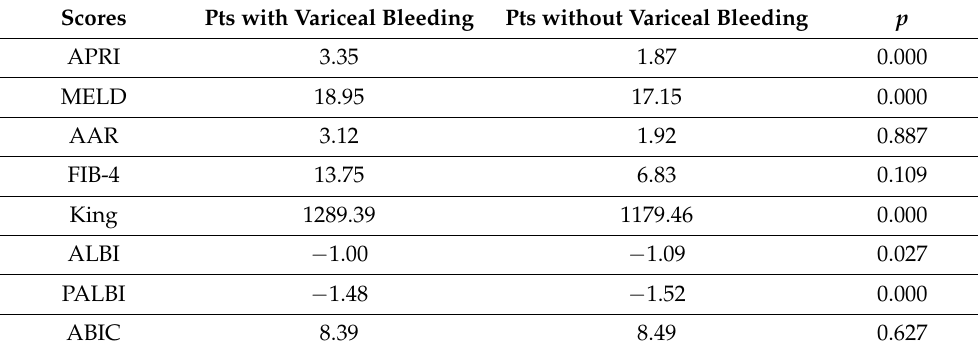
Table 5. Correlation between the scores and the presence of variceal bleeding in patients with liver cirrhosis.